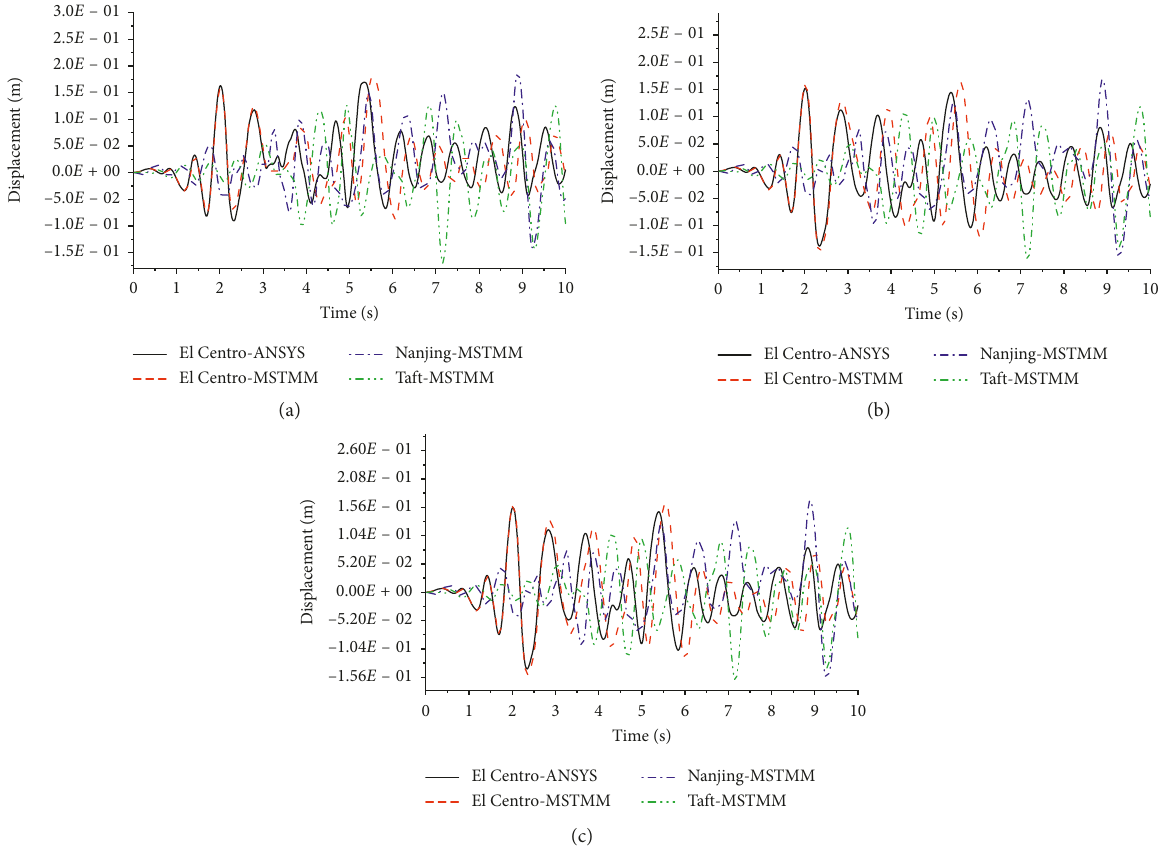
2 ). (a) 100mm,(b) 200mm, and